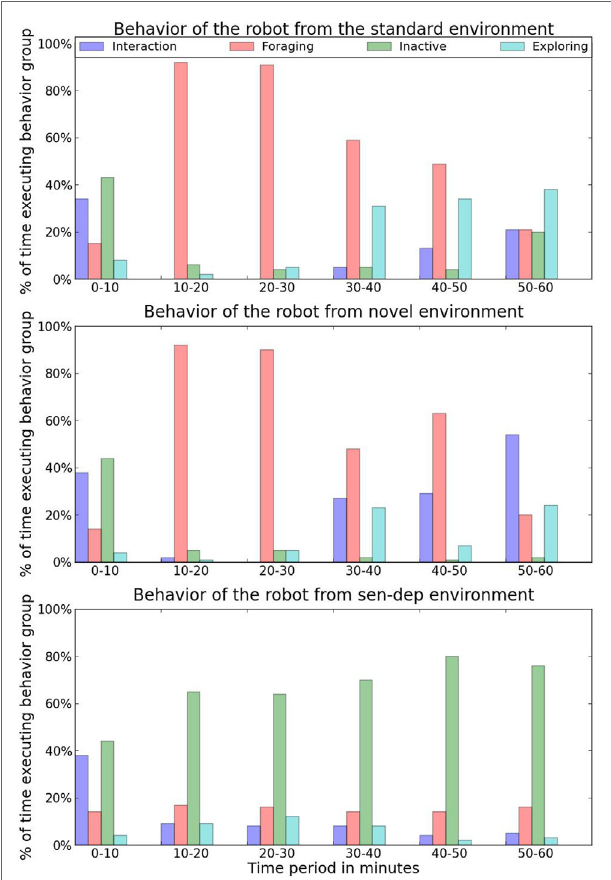
FigUre 8 | The type of behavior executed by each robot during each 10 min period . As previously stated, the robot has no explicit behaviors; instead, behaviors executed by the robot have been classified into four general groups. Interaction includes any purposeful movement toward or contact with an aspect of the environment, foraging refers to any behavior that deals with the recovery of a homeostatic variable, this includes consuming, moving toward and searching for a resource, exploration includes any movement-based behavior, while finally inactive is any period where the robot remains stationary without consuming or engaging in